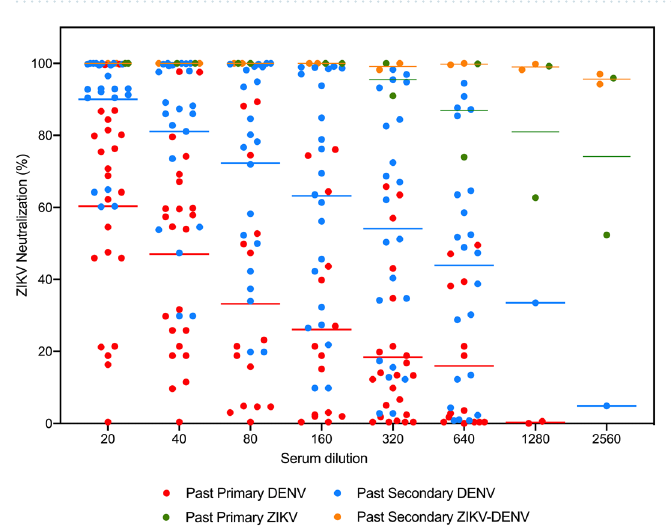
Figure 5. ZIKV-neutralizing activity of serum samples. Comparison of ZIKV-neutralizing activity in subjects with serostatus indicative of past primary DENV serotype 1, 2, or 3 (red dot), past secondary DENV (blue dot), past primary ZIKV (green dot), and past secondary ZIKV and DENV (orange dot) infection . Each dot represents an individual sample. Horizontal bar represents the mean (N =